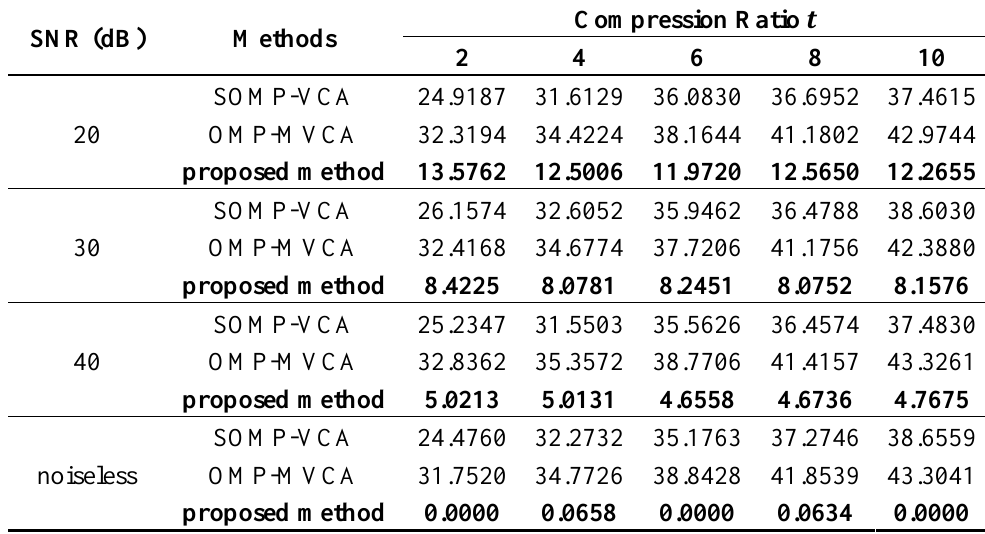
Table 3. Urban HSI: the rmsSAE of the proposed method, SOMP-VCA method and OMP-MVCA method under different noise